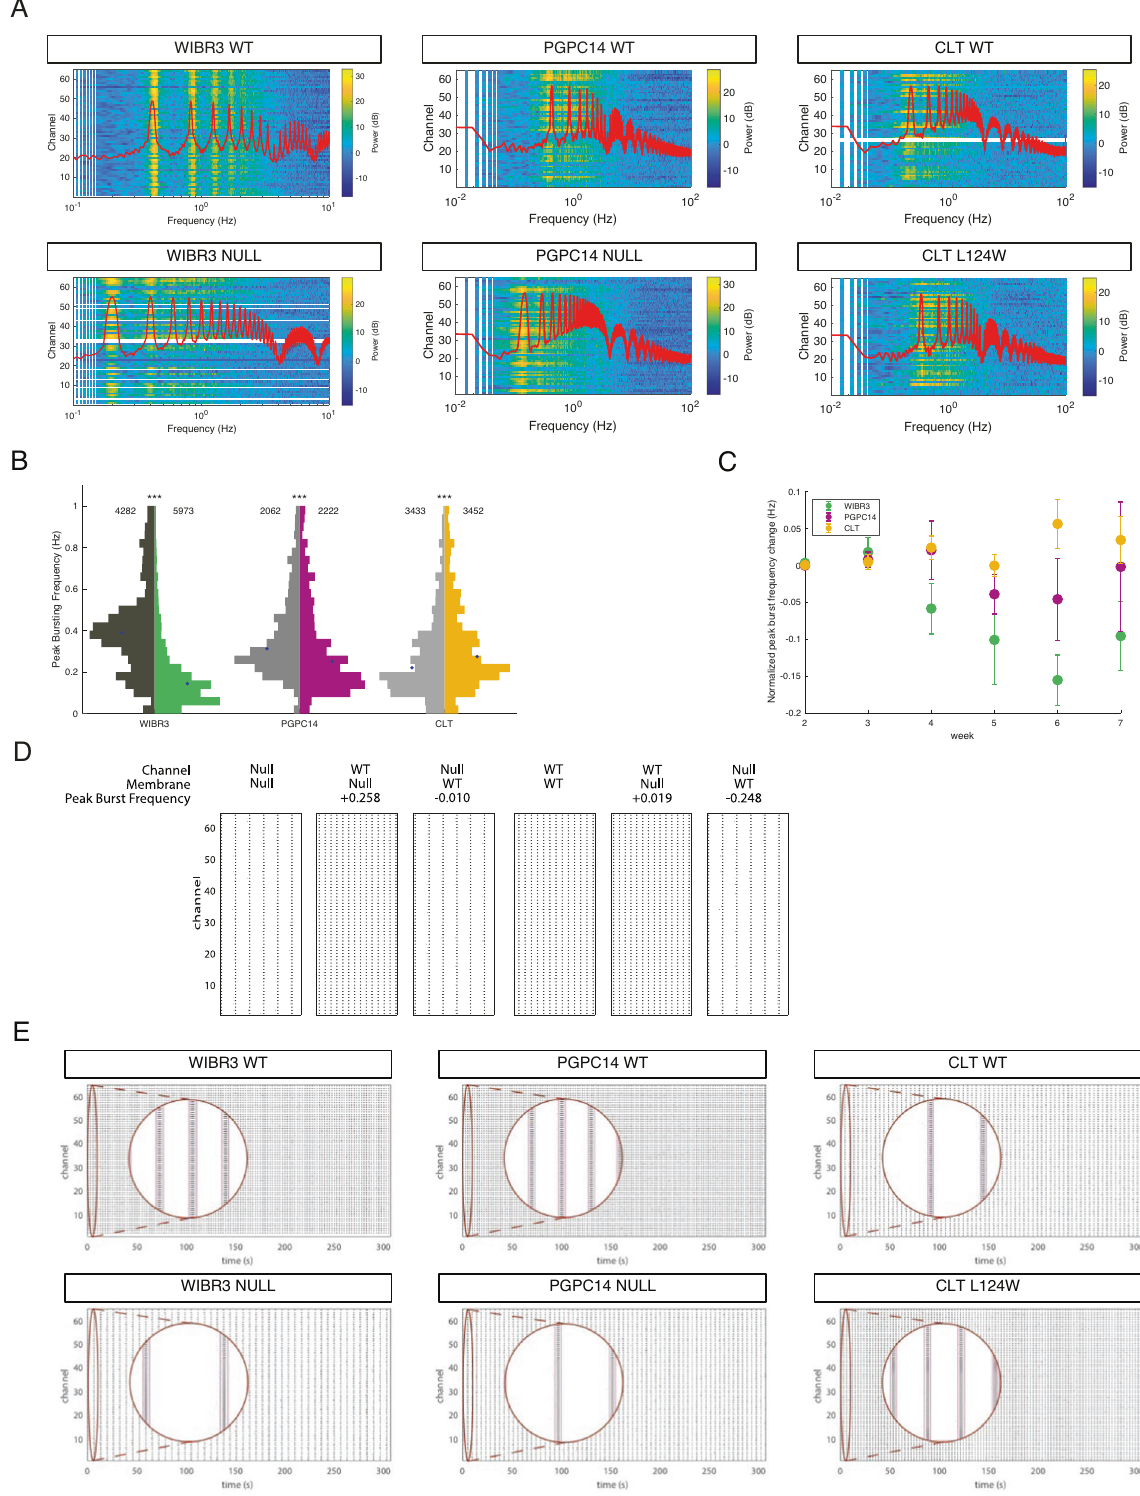
connectivity. First, to test whether the observed differences in peak burst frequency in RTT networks were based on changes to altered intrinsic properties (for example voltage-gated Na + and K + currents, capacitance or resting membrane potentials) we devel- oped a computational model of excitatory spiking